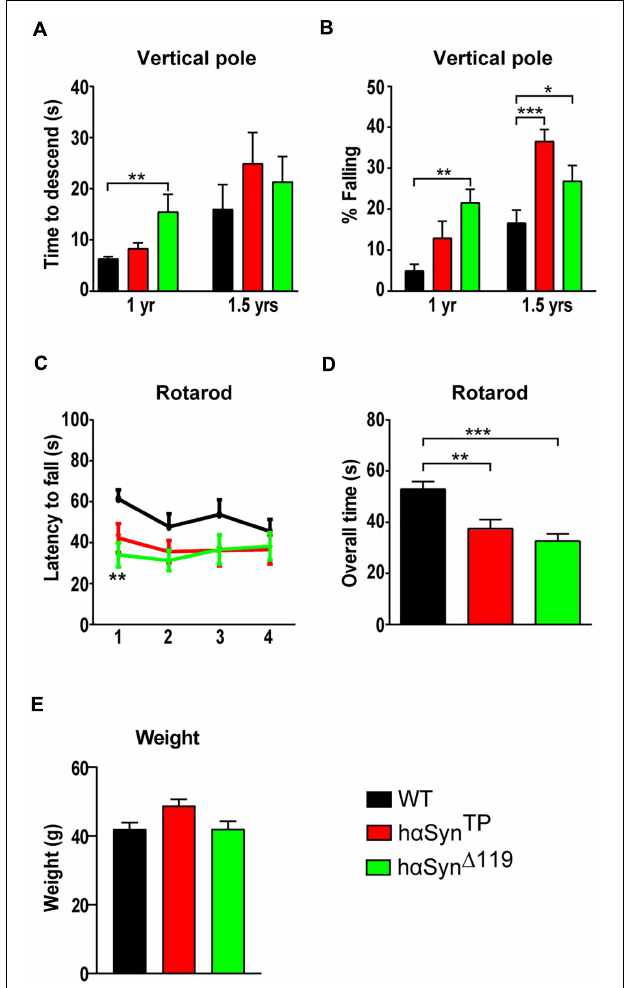
FIGURE 4 | Progressive and age-dependent motor impairment in h α Syn TP and h α Syn (cid:49) 119 mice at 1 and 1.5 years of age. (A,B) Vertical pole test at 1 and 1.5 years of age. (A) shows the time of decent and (B) the percentage of mice falling. Group comparisons using 1 way ANOVA with Tukey’s multiple comparisons test (A) or 2-way ANOVA with Bonferroni’s multiple comparisons test (B) . (C) h α Syn TP and h α Syn (cid:49) 119 mice consistently had a shorter latency to fall off the accelerating rotarod compared to WT mice over all four trials. Group comparisons using 2-way ANOVA with Bonferroni’s multiple comparisons test. (D) h α Syn TP and h α Syn (cid:49) 119 mice spent overall significantly less time on the accelerating rotarod than WT mice at 1.5 years of age. Group comparisons using 1-way ANOVA with Tukey’s multiple comparisons test. (E) Weight of 1.5-year-old WT, h α Syn TP and h α Syn (cid:49) 119 mice. Group comparisons using 1-way ANOVA with Tukey’s multiple comparisons test. For all experiments, values represent mean ± SEM. * p < 0.05, ** p < 0.01, and *** p <